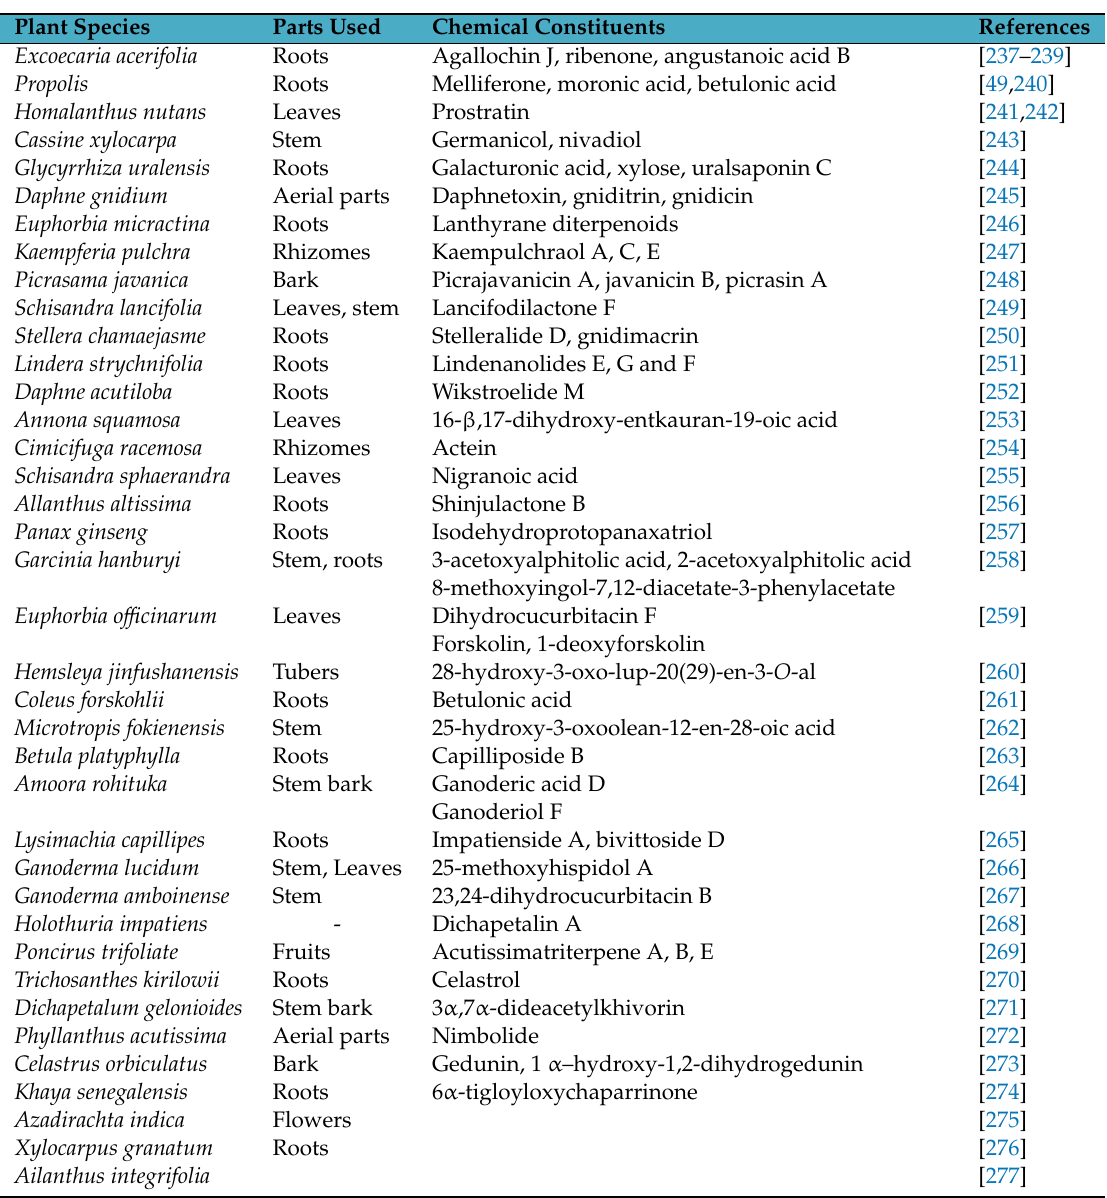
Table 3. Terpenoids act as Anti-HIV